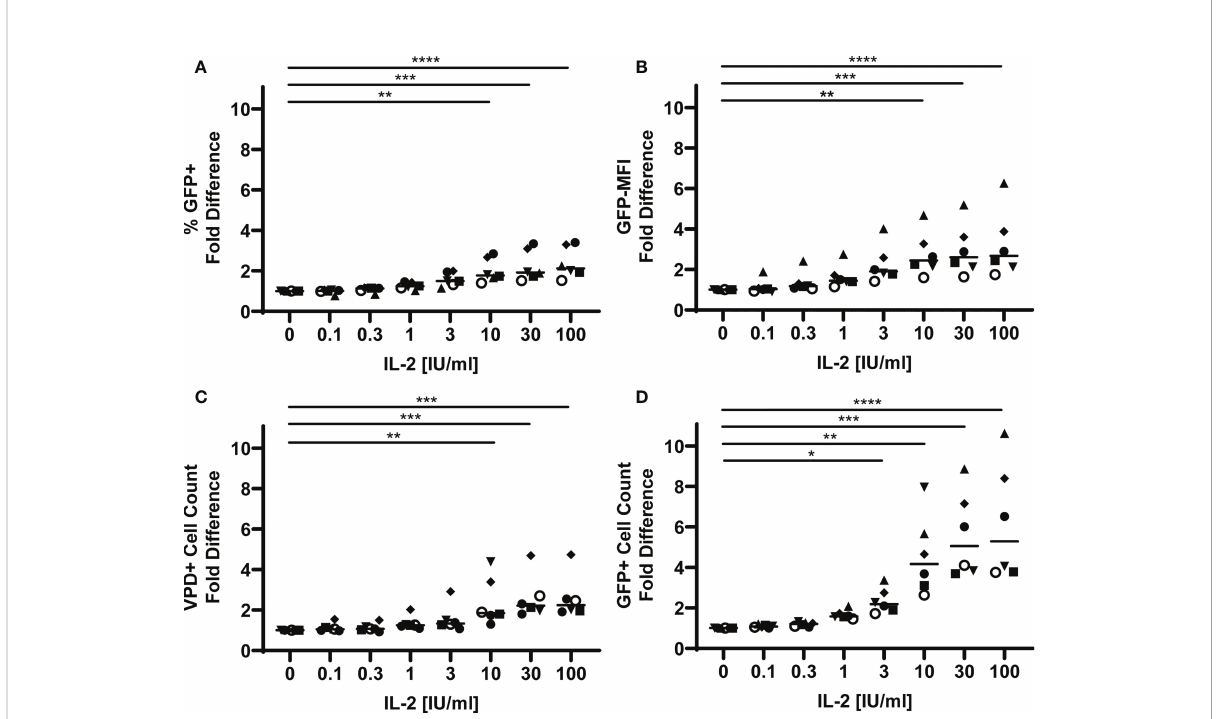
FIGURE 4 IL-2 promotes HIV replication and TFH viability. TFH were spinoculated with CXCR4-tropic HIV GFP reporter virus, labeled with VPD, and cultured for fi ve days at a ratio of 1:1 with uninfected, unlabeled TFH in media supplemented with 10 IU/ml IL-2 and 5 m M saquinavir (n=6). (A) Fold differences of percentages of GFP + VPD + TFH were assessed via fl ow cytometry using the gating strategy in Figure 1. (B) Fold differences of GFP-MFI were determined in GFP + VPD + TFH. (C) Fold differences of VPD + TFH and (D) GFP + VPD + TFH cell counts were determined after fi ve days in culture using absolute counting beads. Symbols denote individual tonsils (n=6). Statistical analyses were performed with Friedman ’ s test and Dunn ’ s multiple comparison test using Graphpad Prism v8 and signi fi cance indicated: *p<0.05; **p<0.01; ***p<0.001;